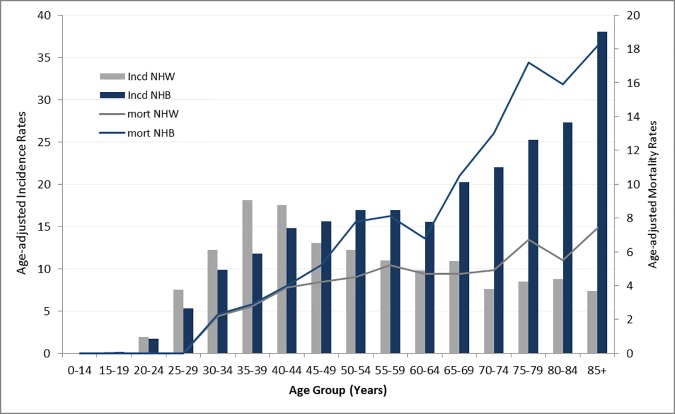
Age-specific cervical cancer incidence and mortality rates in the South by race (2008–2012).Bar graphs represent incidences rates (gray for NHW and navy for NHB) and line graphs represent mortality rates (gray for NHW and navy for NHB).Abbreviations: NHW–non-Hispanic white, NHB–non-Hispanic black.